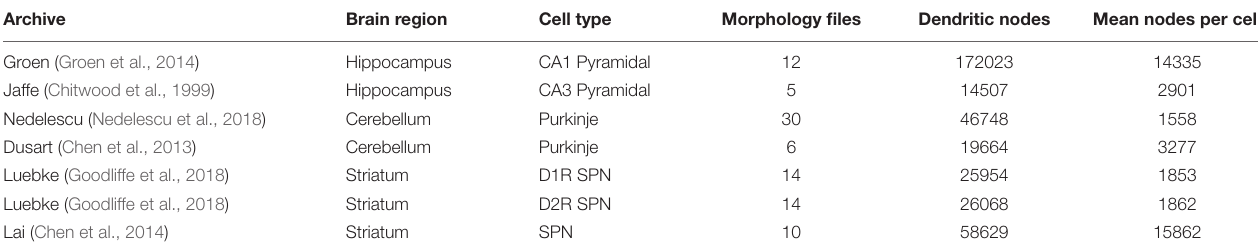
TABLE 1 | Selected NeuroMorpho.org archives for predictive diameter